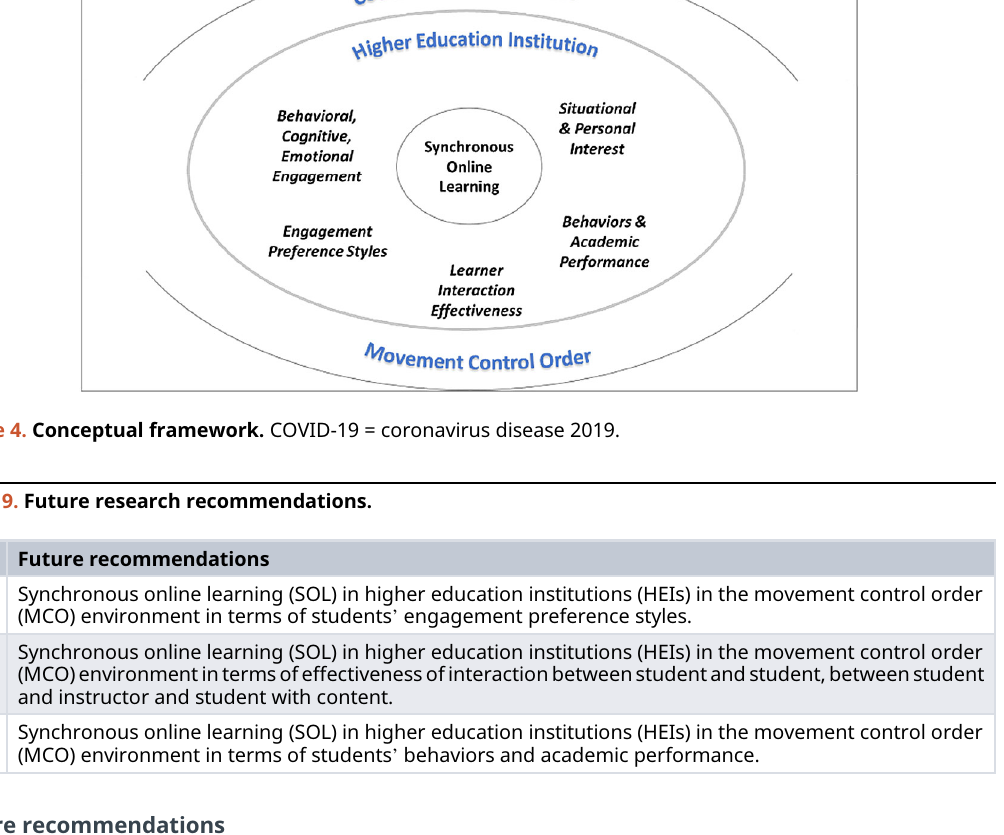
Figshare: PRISMA flow diagram and checklist for ‘ Synchronous online learning during movement control order in higher education institutions: a systematic review. https://doi.org/10.6084/m9.figshare.16752031.v1. 62 Data are available under the terms of the Creative Commons Attribution 4.0 International license (CC-BY 4.0).